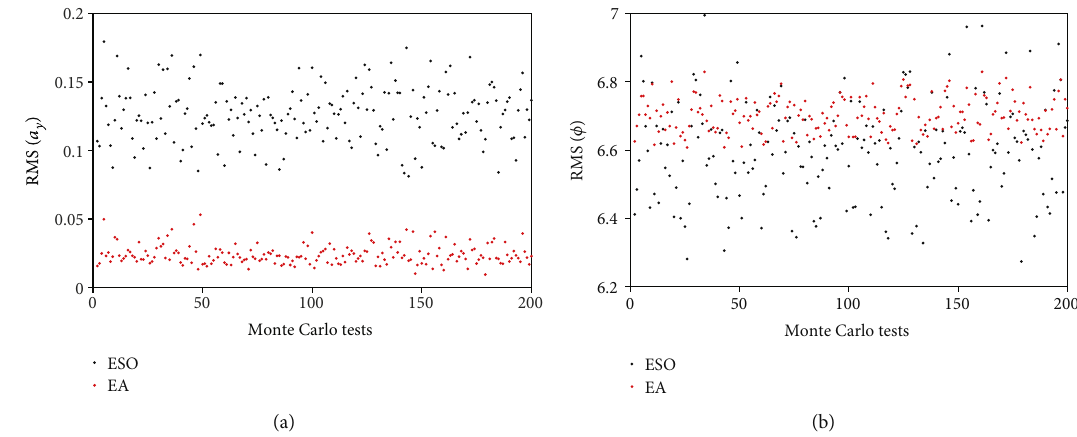
Figure 16: Comparison of MC simulations. (a) RMS of the lateral acceleration control. (b) RMS of the bank angle control.